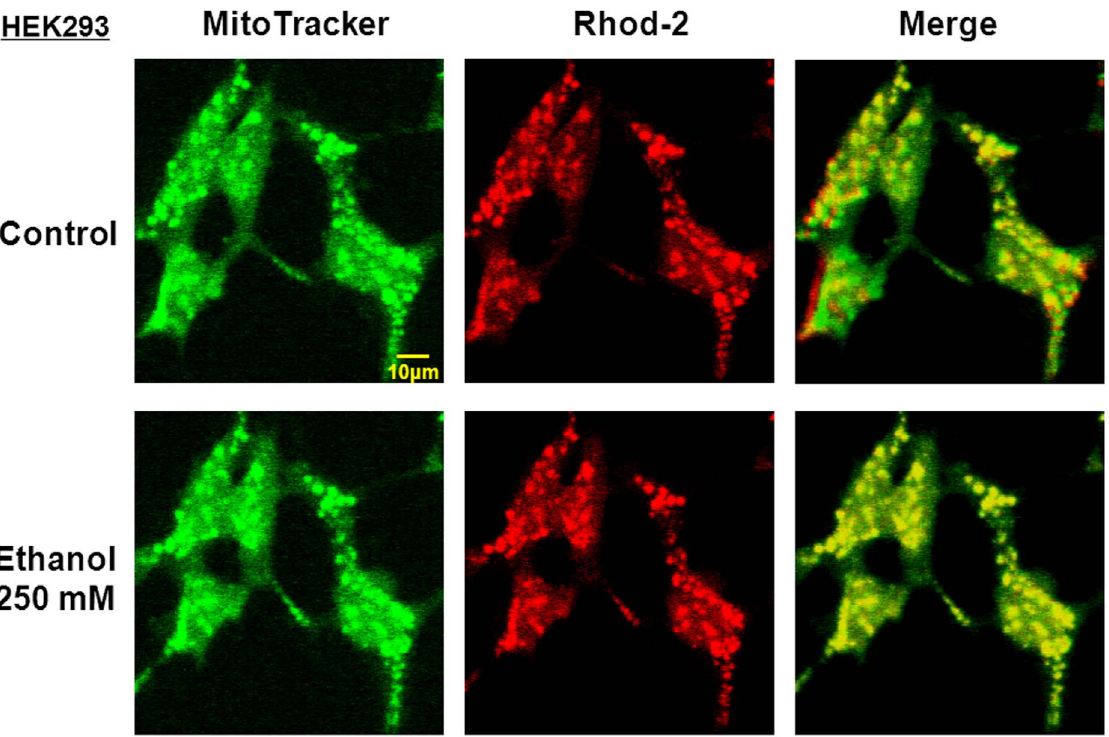
Figure 6. Effect of ethanol on morphological features of HEK293 cells. Cultured HEK293 cells were loaded with Rhod-2 along with MitoTracker green, followed by washing with recording medium and subsequent exposure to 250 mM ethanol for 20 min for observation under confocal laser scanning microscope. Typical pictures are shown in this figure with similar results in 3 independent experiments.